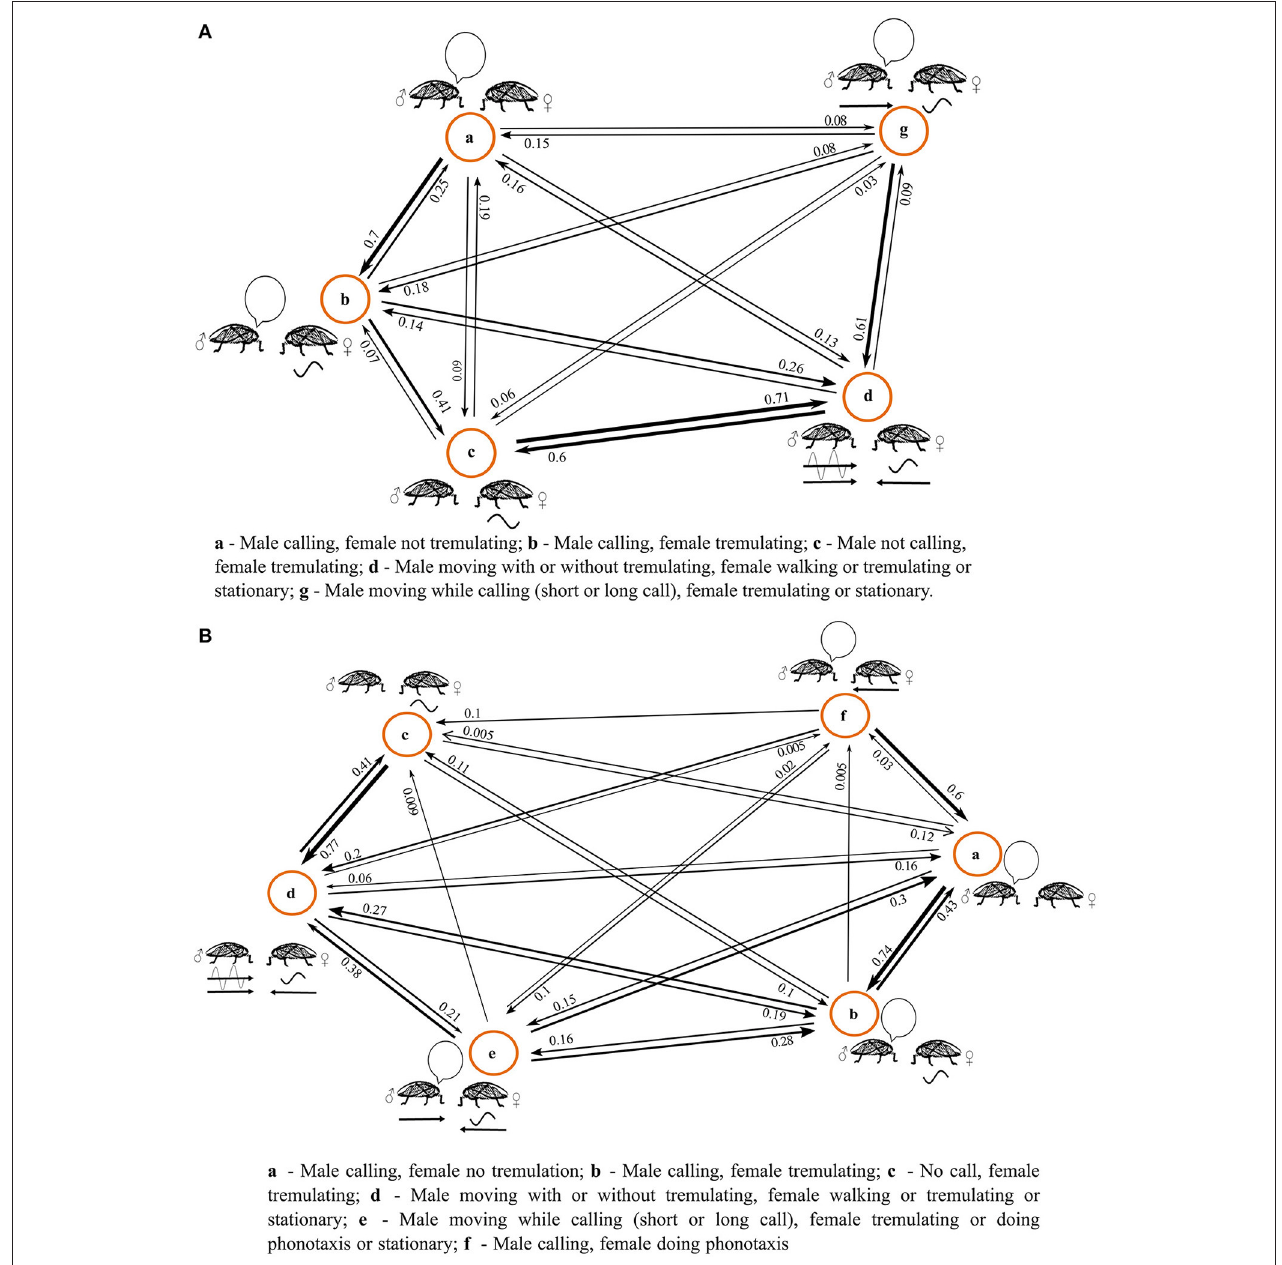
FIGURE 1 | Ethograms of the behavior of the duetting pair at initial separation distances of (A) 4m ( n = 11) and (B) 9m ( n = 10), constructed using a First Order Markov Model. The numbers next to the arrows are probability values which give (NOT gives) the probability of transitioning from one behavior to the other. The thicknesses of the arrows are in accordance with the probability values they